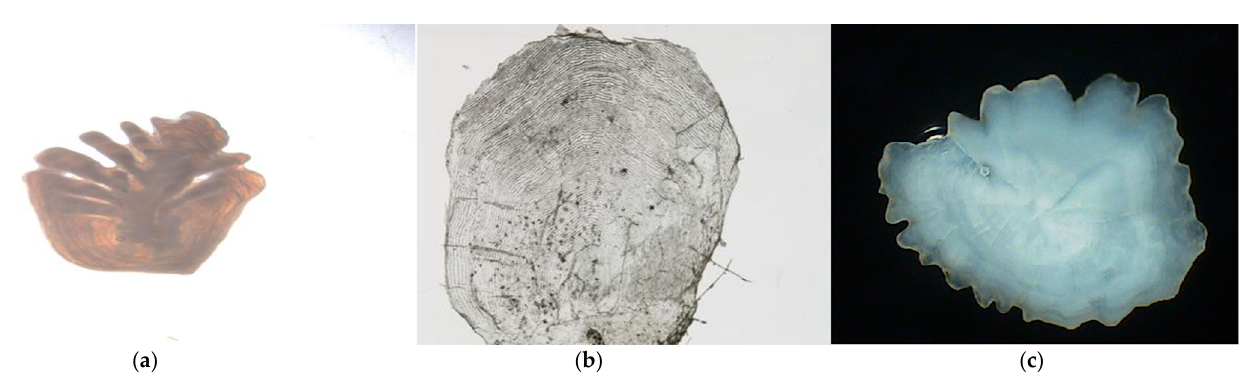
Figure 1. Landing page of the DeepOtolith platform (http://otoliths.ath.hcmr.gr/, accessed on March of 2022), which applies deep learning techniques to predict fish age from otolith images.